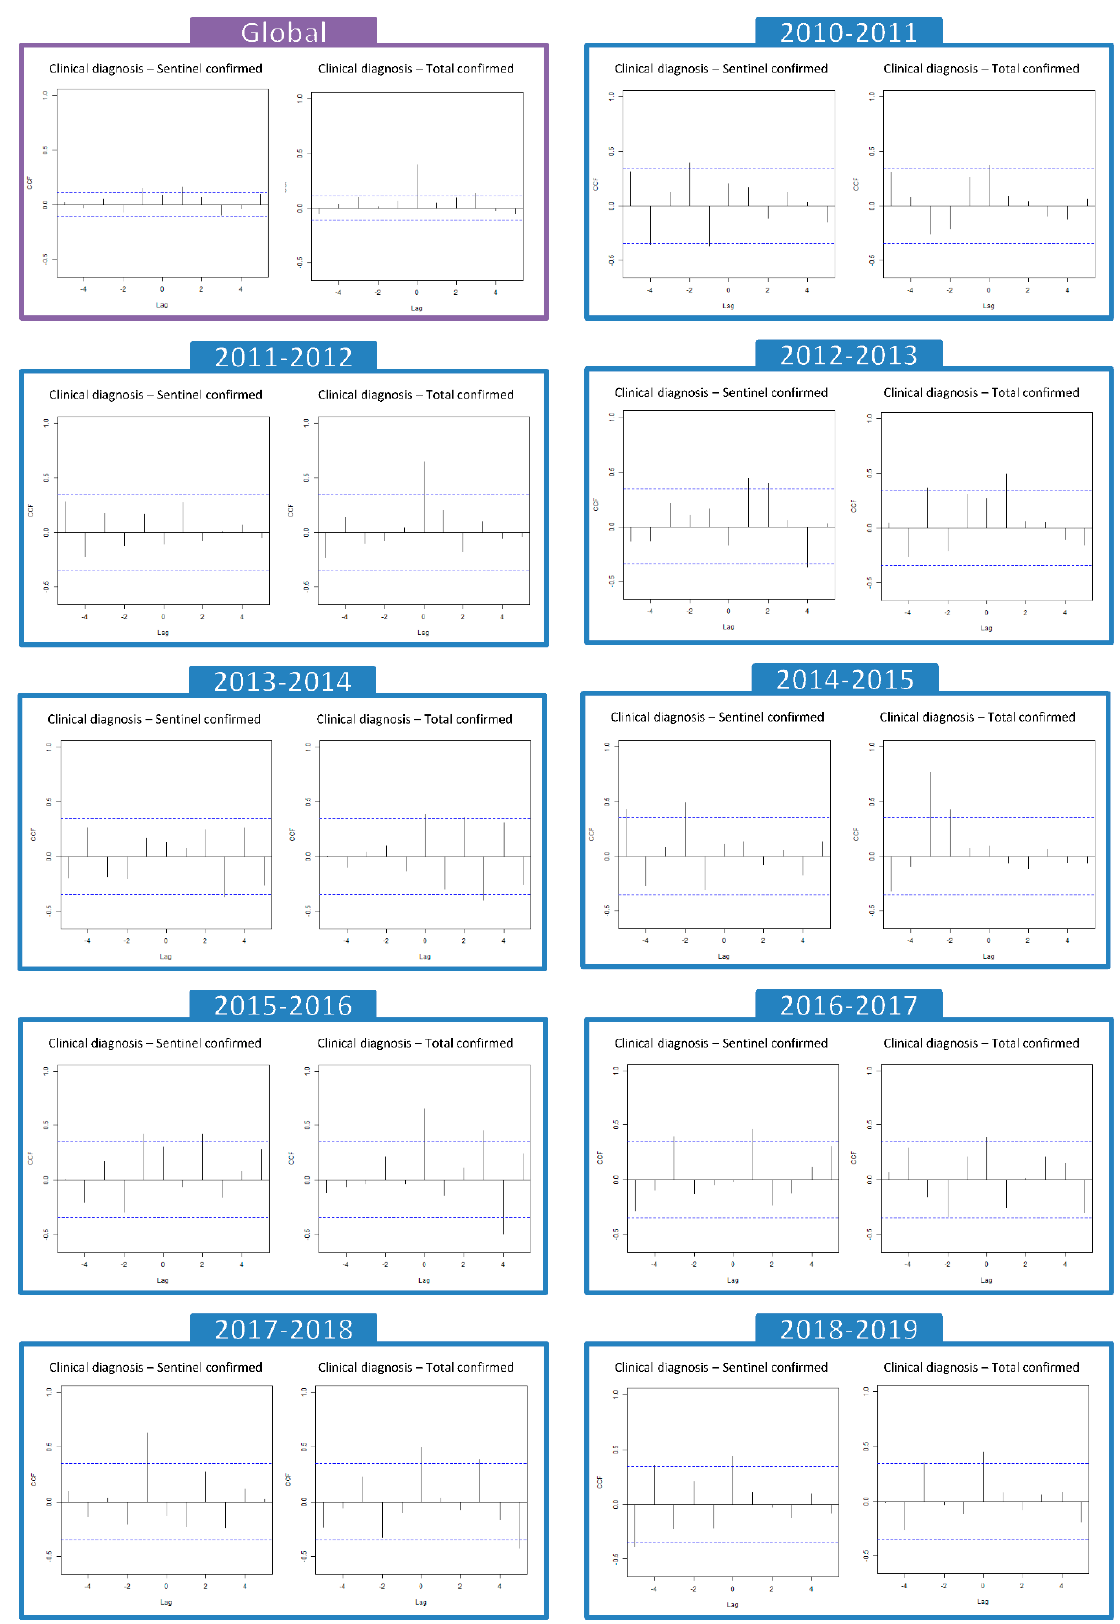
Figure 3. Time lag analysis between clinical diagnoses rate and confirmed cases rate for the global of influenza seasons and for each influenza season. Cross-correlation results. CCF: